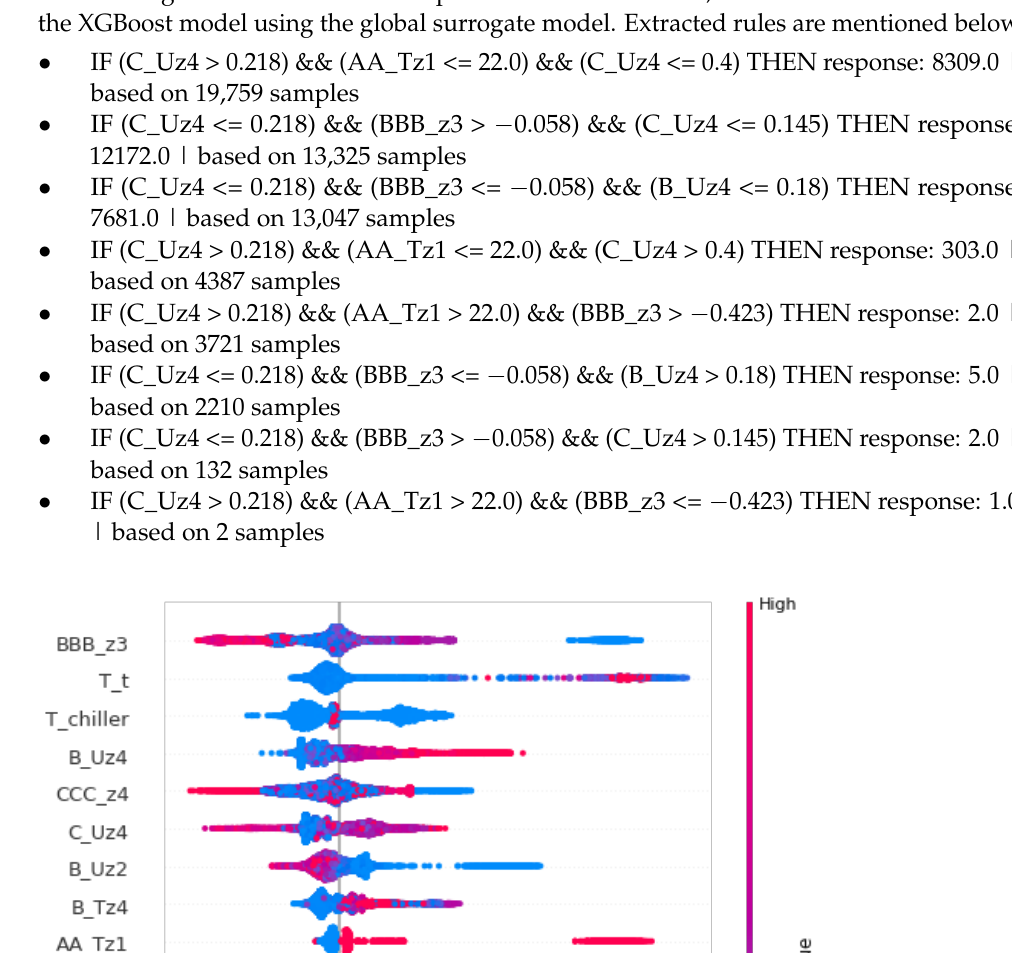
IF (C_Uz4 > 0.218) && (AA_Tz1 <= 22.0) && (C_Uz4 <= 0.4) THEN response: 8309.0 |